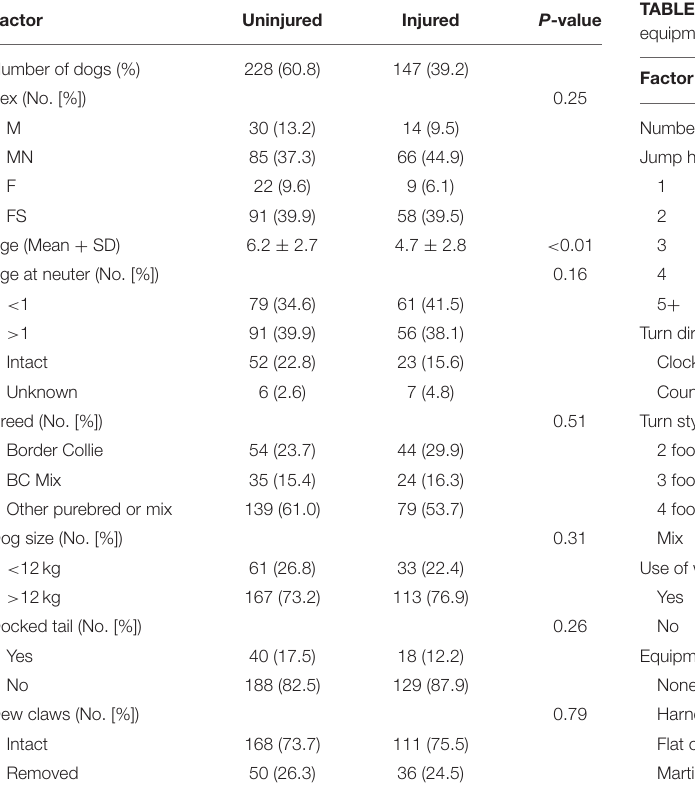
TABLE 1 | Univariate analysis assessing canine subject demographic/anatomic factors vs. injury